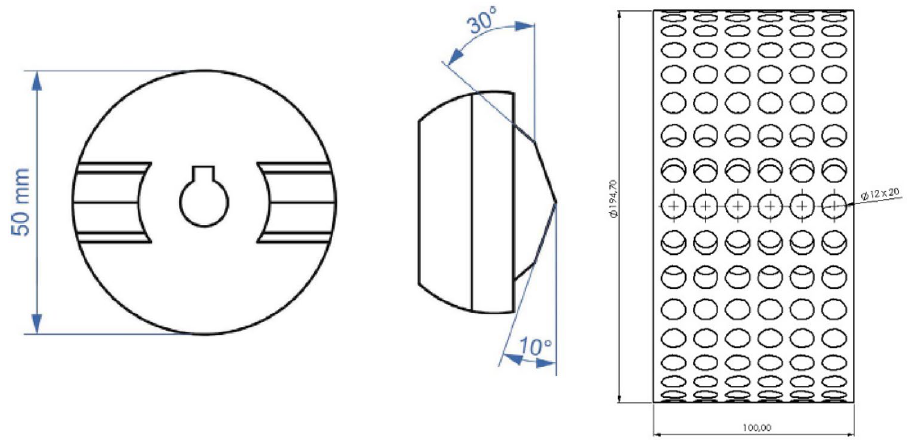
Figure 2. Rotors of SCR (left and middle) 33 and BCR (right)